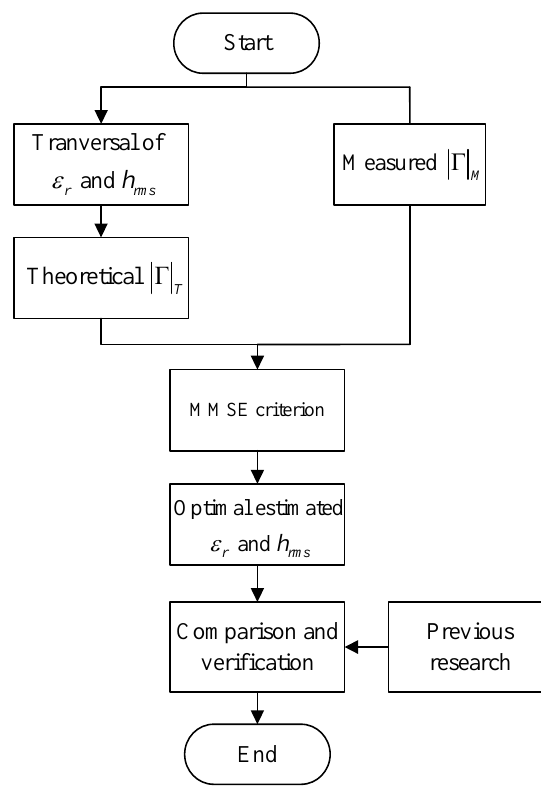
Figure 2. The flow chart of dataset